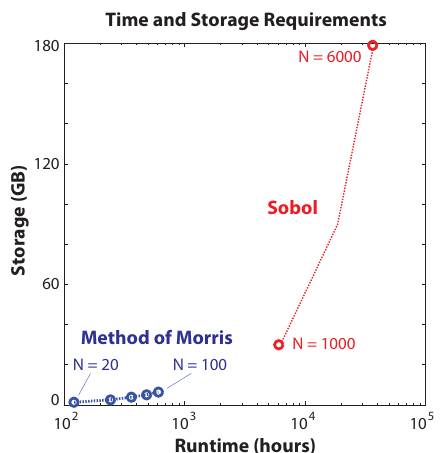
Fig. 6. Computation time (hours) and storage (gigabytes) required for each experiment. The method of Morris with N =20 repre- sents a factor of 300 computational savings compared to the Sobol 0 method with N